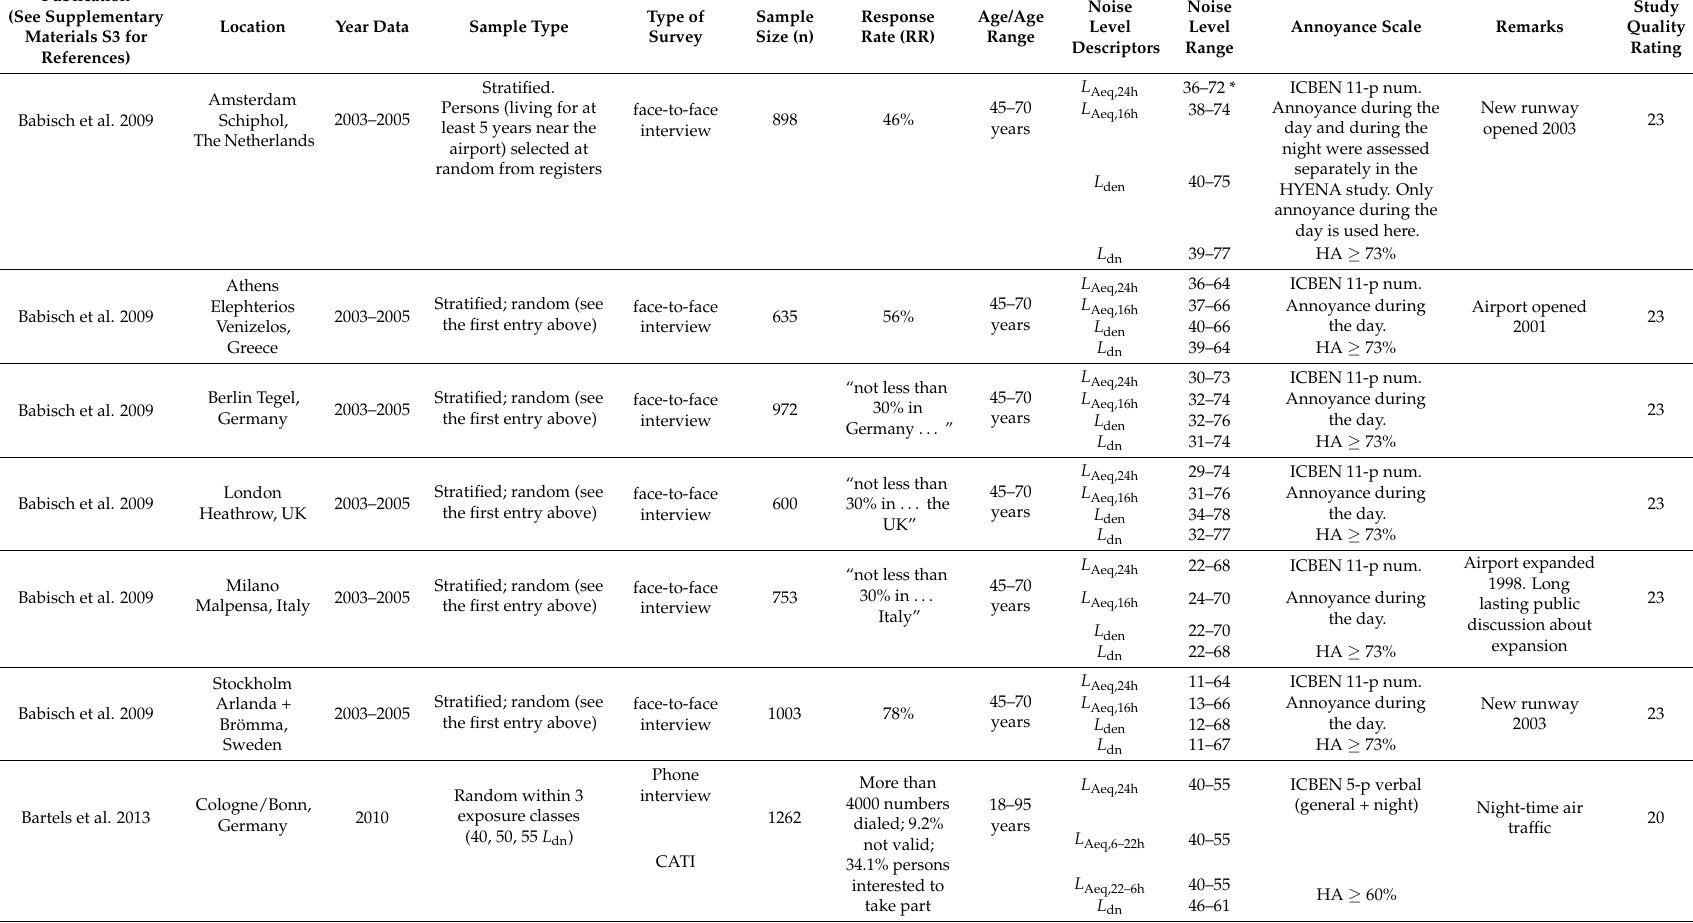
Table 1. Aircraft noise annoyance studies